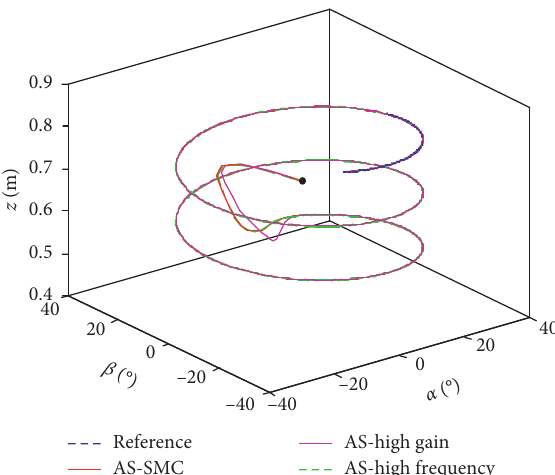
Figure 7: Desired trajectory in Cartesian space.